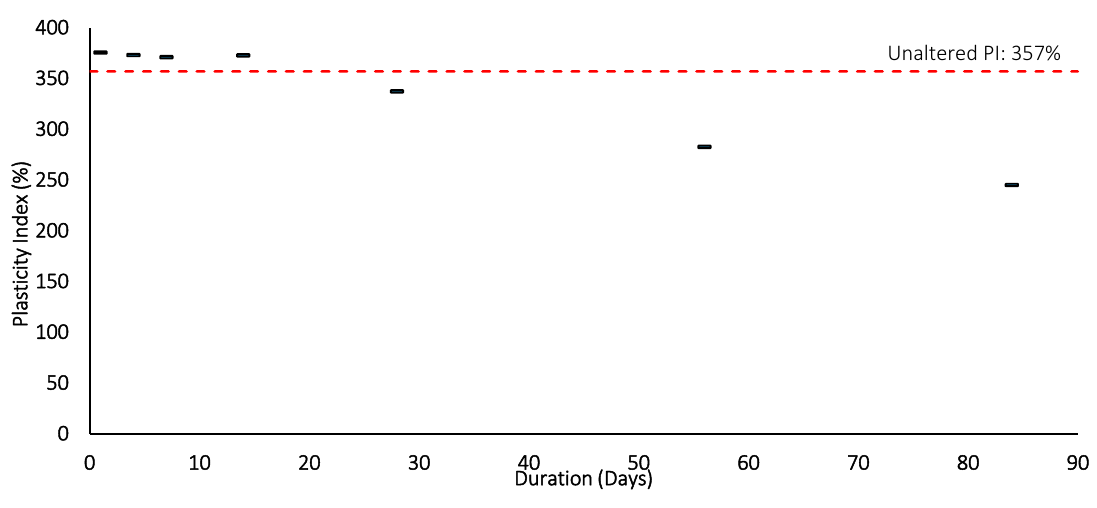
Figure 15. Plasticity index after Thermal loading (105 °C) and duration.